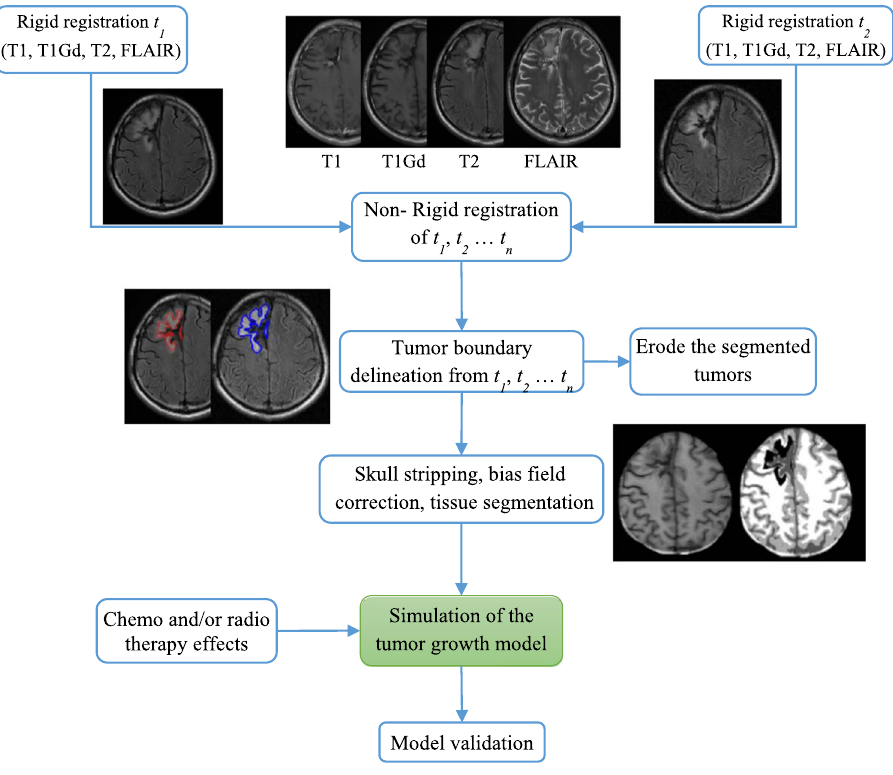
Figure 1. The processing pipeline of the proposed glioma growth